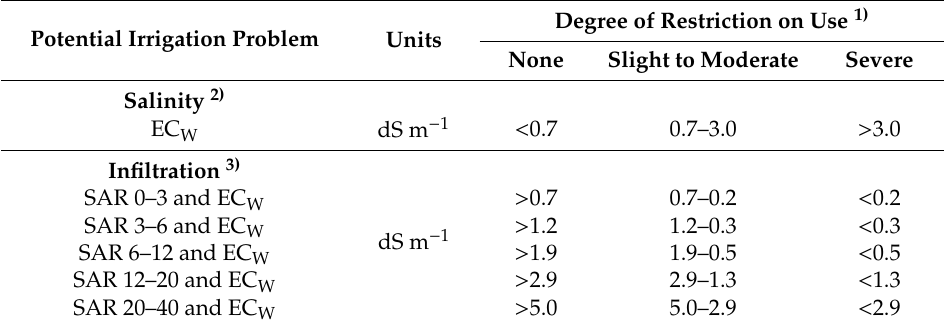
Table 4. Excerpt of the FAO guidelines for interpretation of water quality for irrigation (adapted from Ayers and Westcot